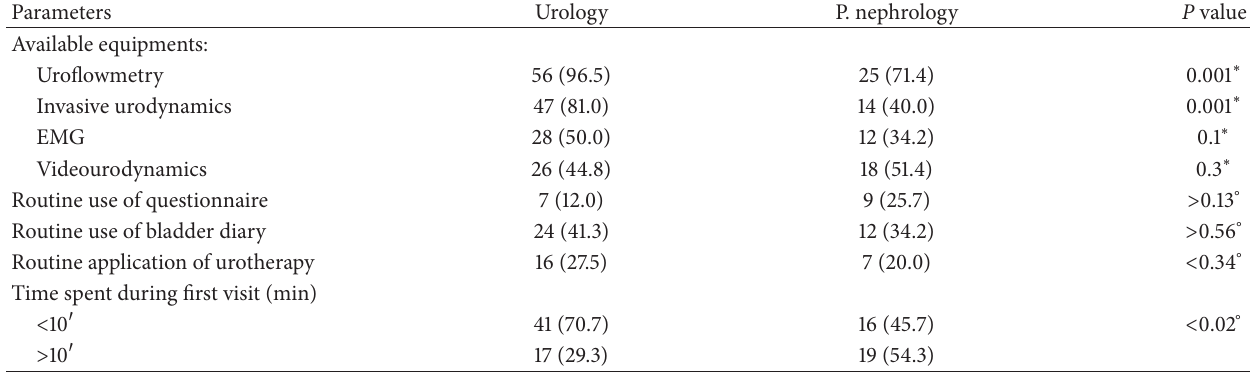
Table 1: Comparison of the parameters between urology and paediatric nephrology